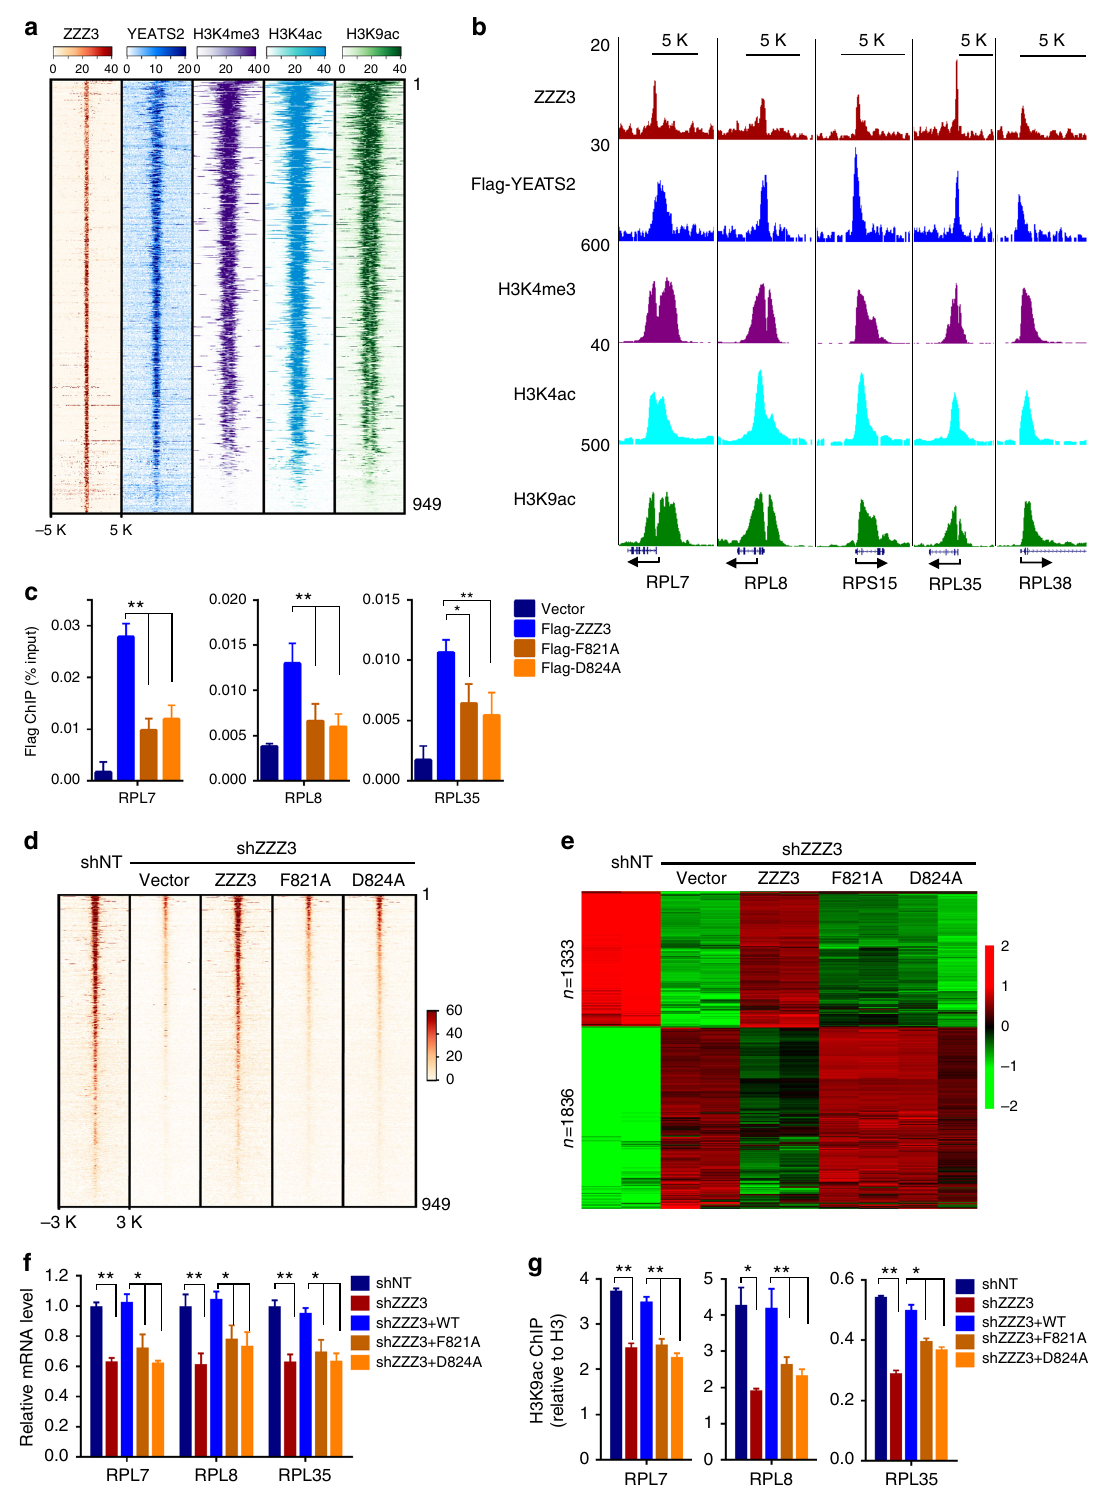
RNA-seq data uncovered 116 downregulated genes and 49 upregulated genes likely to be direct targets of ZZZ3 (Supple- mentary Fig. 9a and Supplementary Data 2). While the upregulated direct target genes are not signi fi cantly enriched in any pathway, the downregulated 116 genes, including 39 ribosomal protein genes, are again enriched in ribosome biogenesis (Supplementary Fig. 9b –